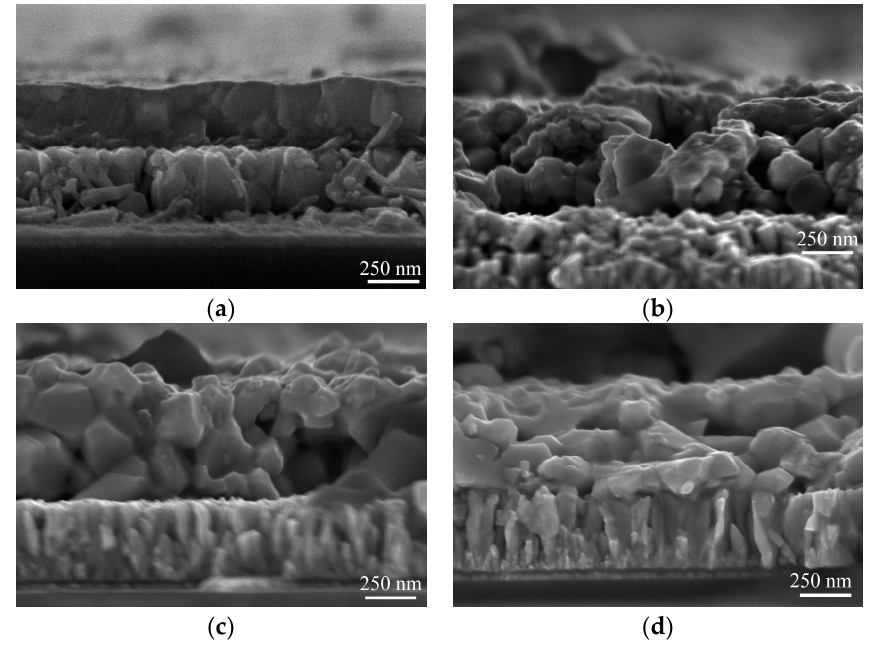
Figure 6. Cross-section SEM images of Ag and Mn co-doped Cu 2 ZnSnS 4 samples with ( a ) Ag / (Ag + Cu) = 0; ( b ) Ag / (Ag + Cu) = 1 / 3; ( c ) Ag / (Ag + Cu) = 2 / 3; and ( d ) Ag / (Ag + Cu) = 1.